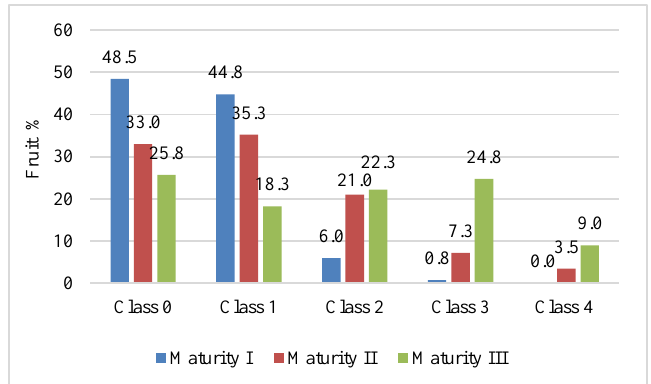
Figure 4. Effect of different harvest times (maturity classes) on chilling injuries percentage of Bergarouge apricot.